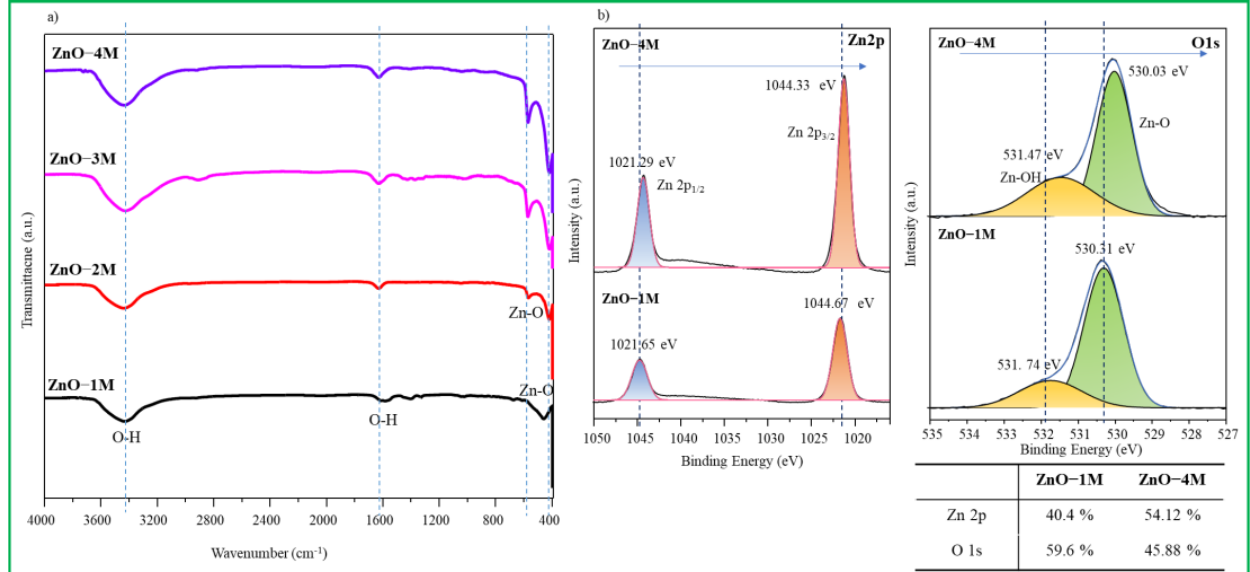
Figure 2. ( a ) FTIR spectra of synthesized ZnO particles. ( b ) XPS spectra of synthesized ZnO particles.